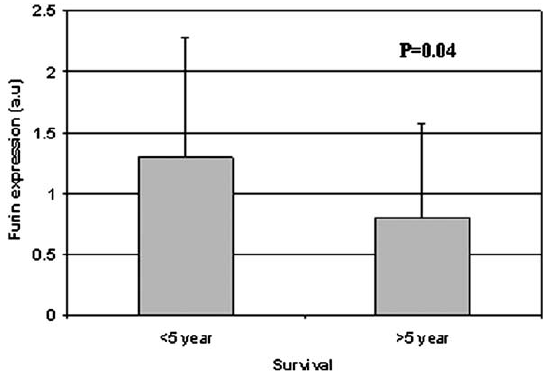
Fig. 6. Immunohistochemistry quantitation. Furin expression was scored 0 to 2 according to the immunostaining intensity. Note higher furin expression in the group that survived less than five